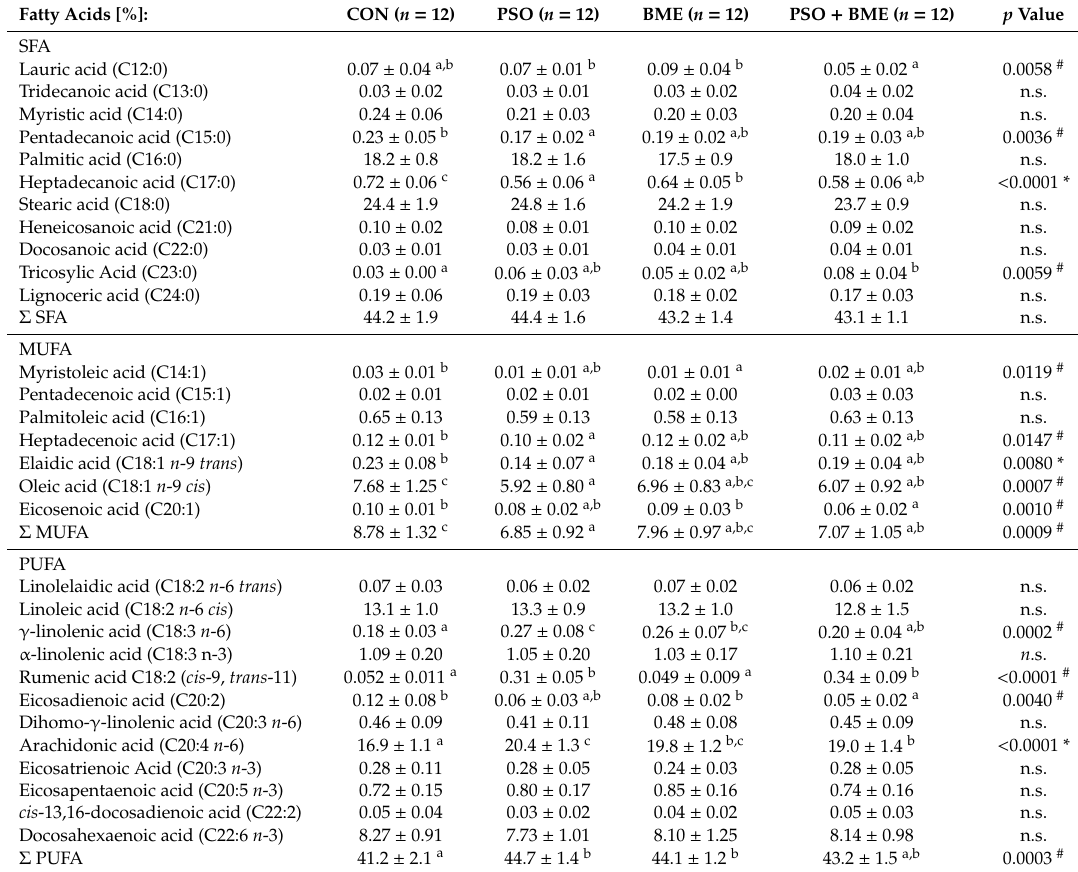
Table 3. Fatty acids profile in hepatic microsomes of experimental groups.